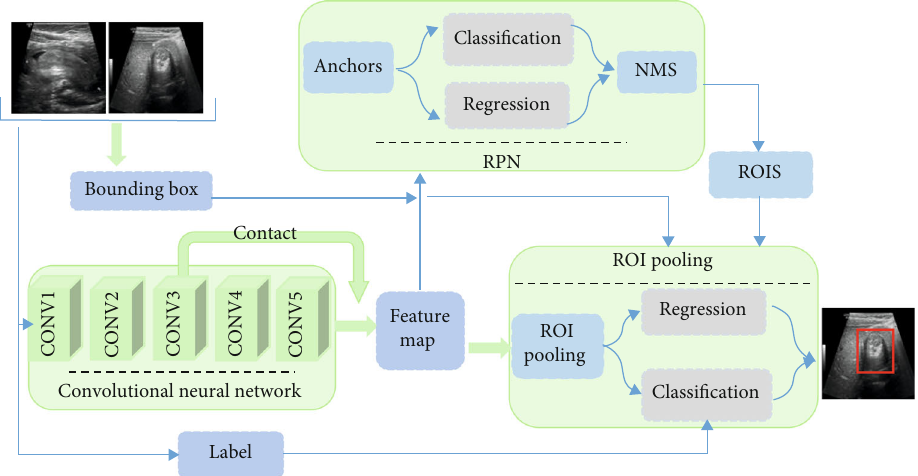
Figure 3: Network structure. The main structure of the network consists of three stages: backbone for feature extraction network, region proposal network (RPN), and region of interest (ROI) pooling. Input the image into the VGG16 to get the feature map, use RPN to generate the anchors, after Nonmaximum Suppression (NMS) to obtain ROIs, project the ROIs onto the feature map to get the feature matrix, scale each feature matrix to 7 × 7 through the ROI pooling, and then fl atten the feature map to get the prediction result through a series of fully connected layers.